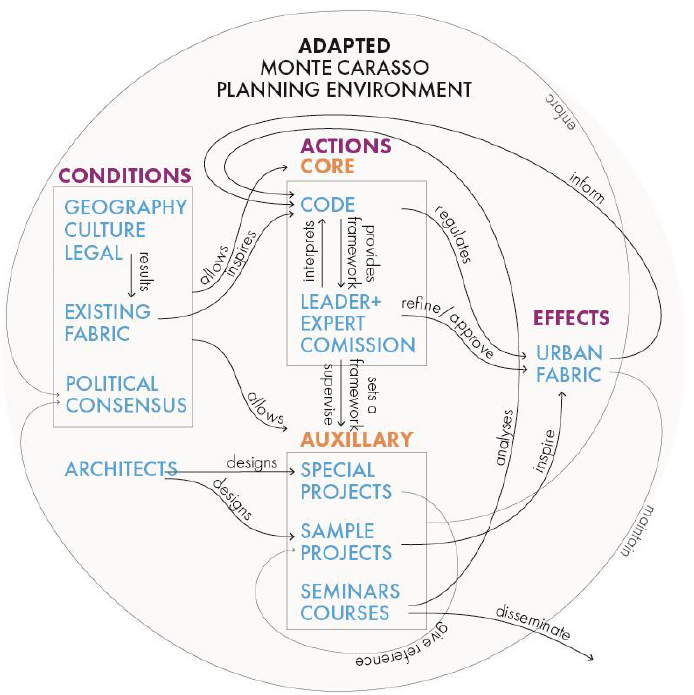
Figure 9. Proposal of adaptation Monte Carasso spatial environment’s mechanics to the general context of other small towns. Source: Author.